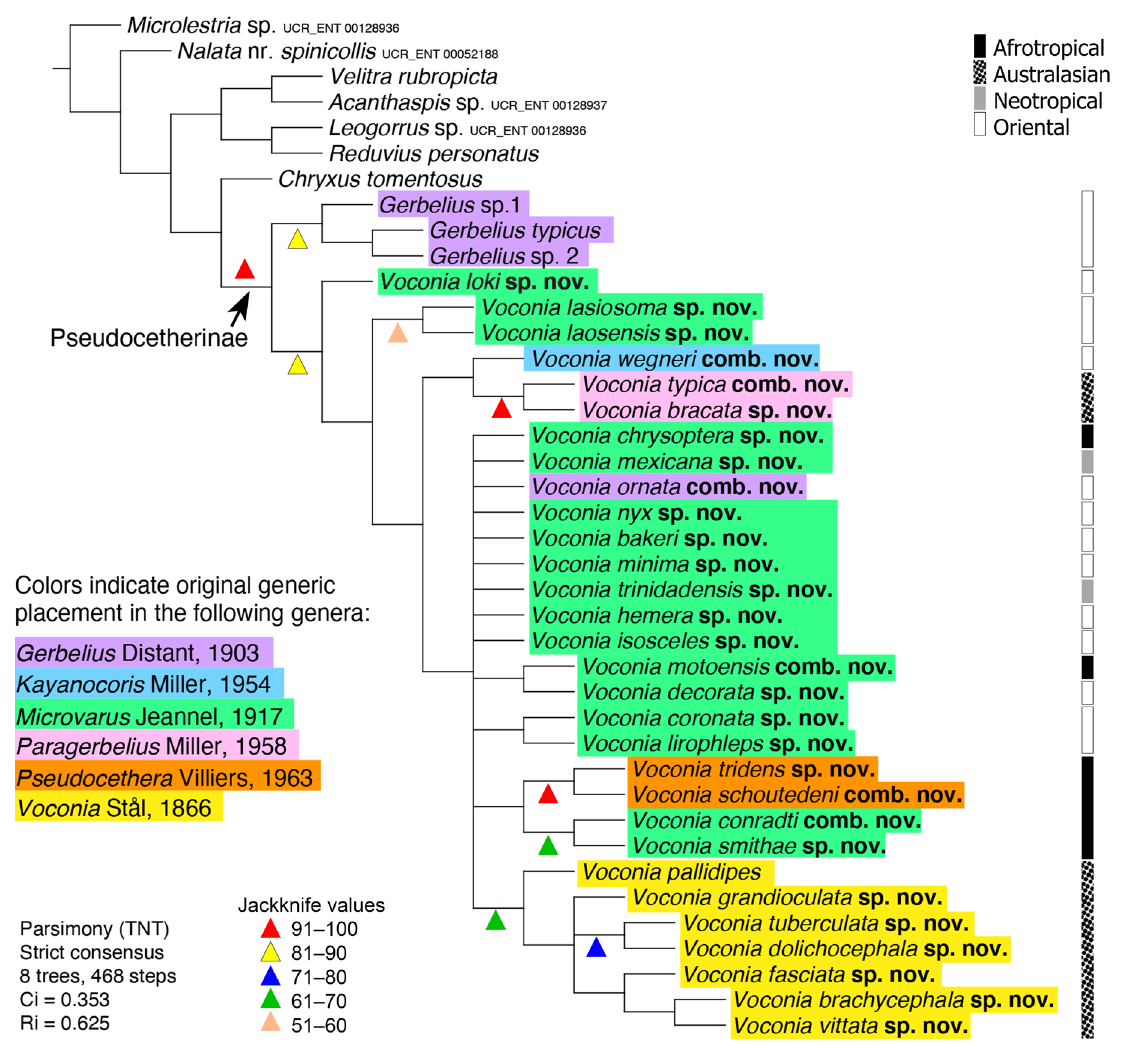
Fig. 1. Strict consensus tree resulting from equal weighting analysis. Jackknife values over 51 are reported for tree one of